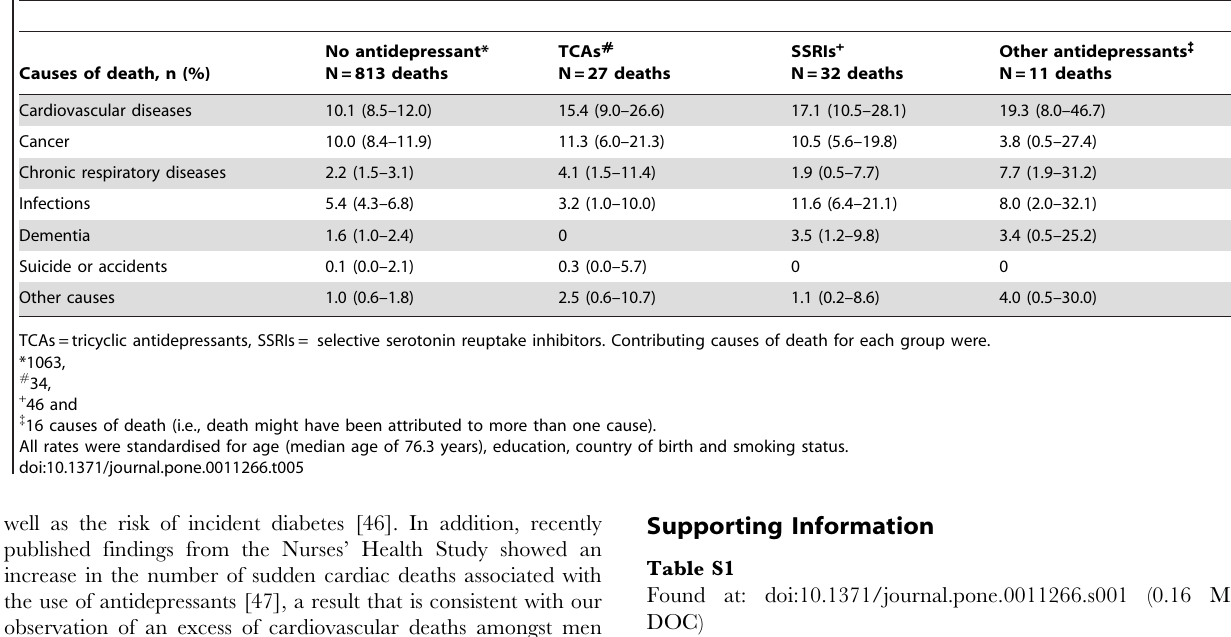
Table 5. Mortality rates (95% confidence interval) per 1,000 persons per year according to antidepressant group use.